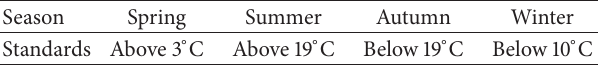
Table 2: Temperature standard for four meteorological seasons. Season Spring Summer Autumn Winter Standards Above 3 ∘ C Below 10 ∘